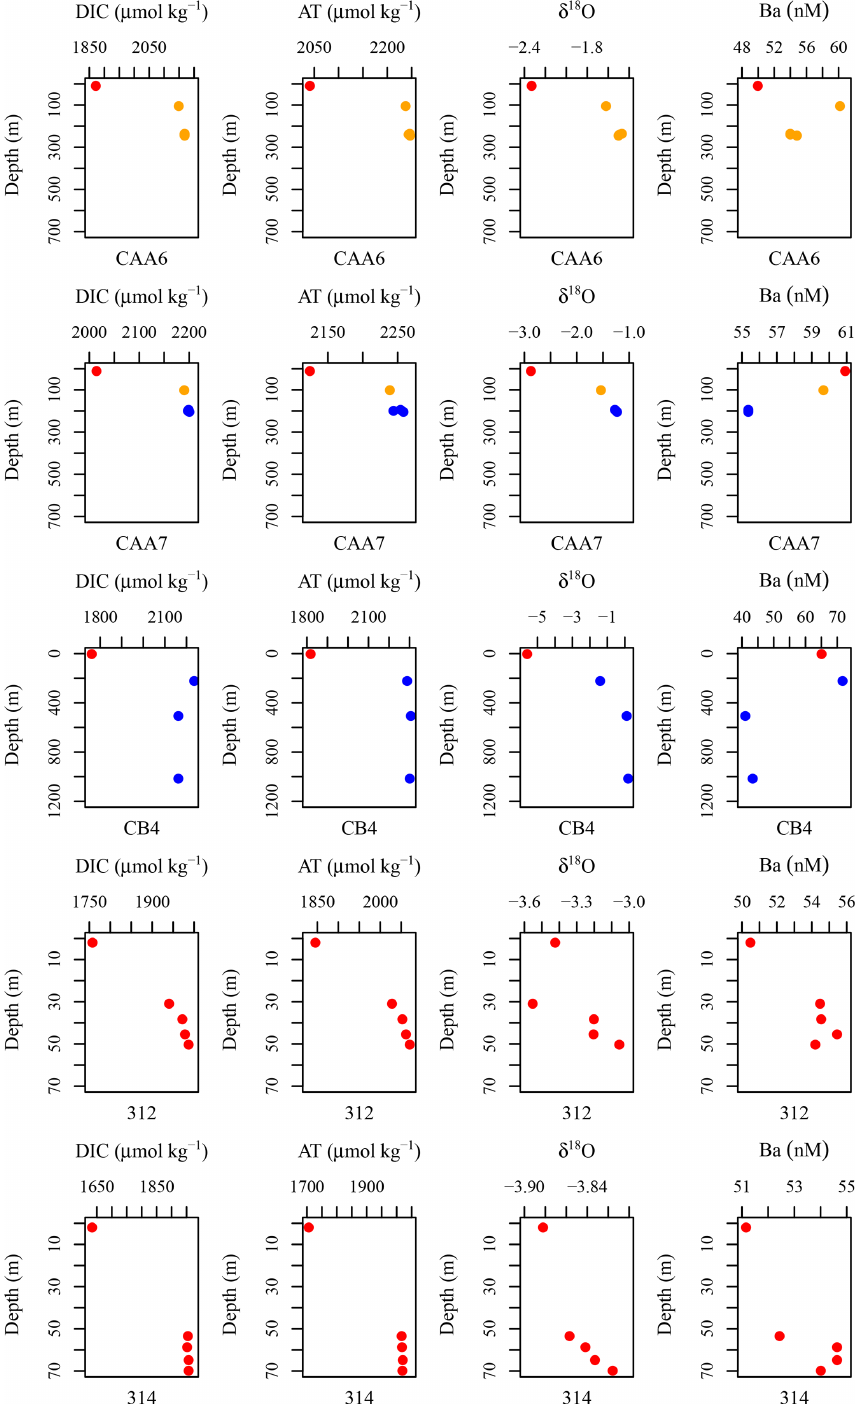
Figure A1. DIC (µmolkg − 1 ), AT (µmolkg − 1 ), δ 18 O, and Ba (nM) plotted against depth for each station including CAA1, CAA2, CAA3, CAA4, CAA5, CAA6, CB4, 312, and 314, where profiles were taken throughout the 2015 GEOTRACES cruise in the Canadian Arctic Archipelago. Colors indicate the water masses present at the sampled depths: red is the polar mixed layer (PML), yellow is the upper halocline layer (UHL), and blue is the Atlantic layer